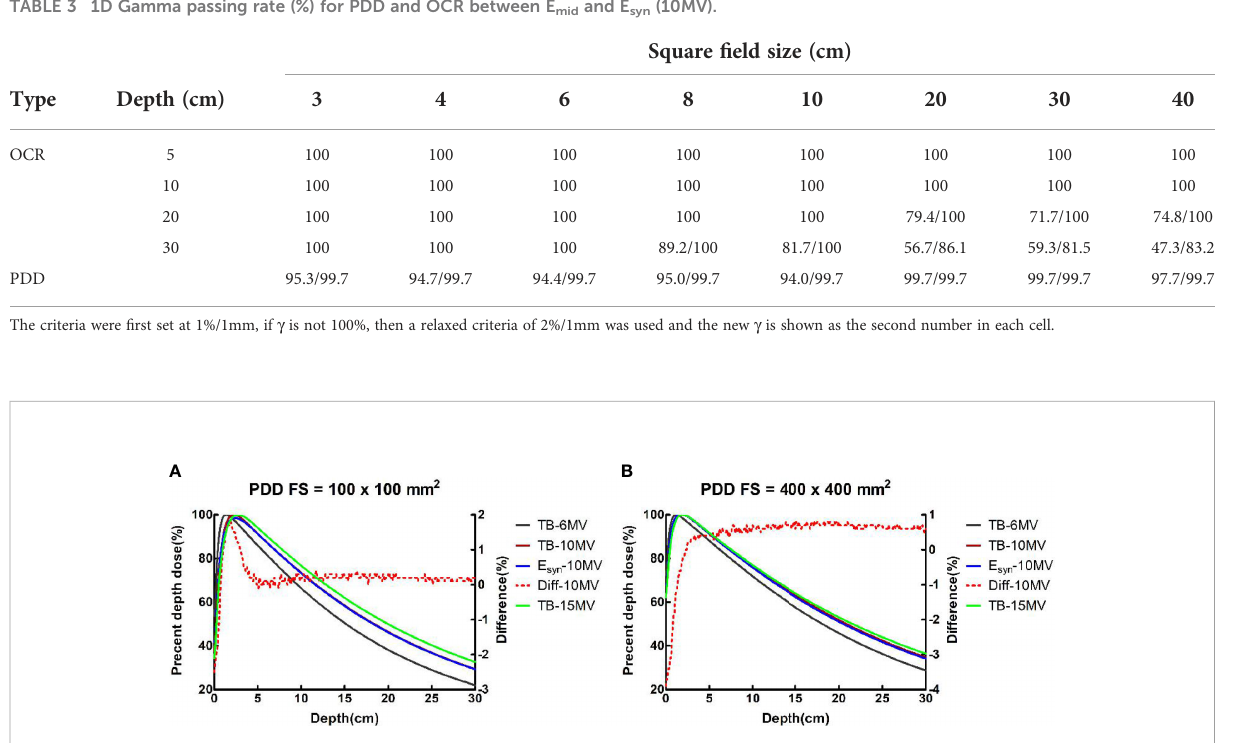
TABLE 3 1D Gamma passing rate (%) for PDD and OCR between E mid and E syn (10MV).